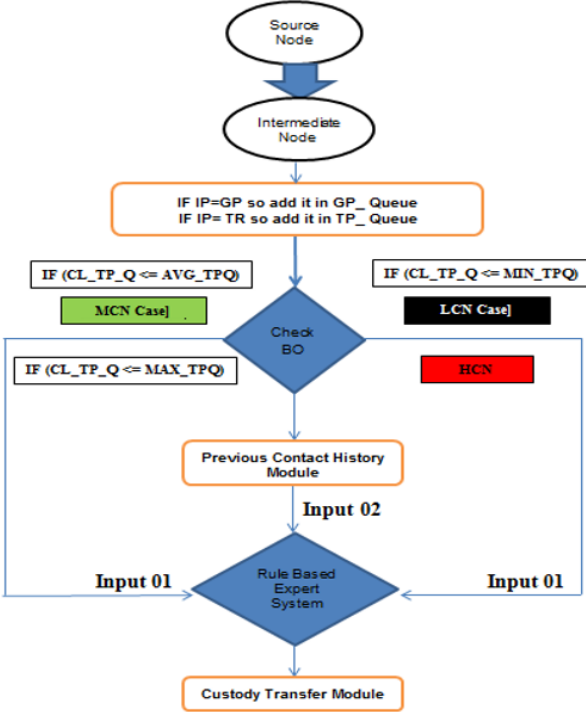
Fig 1: Artificial Intelligence Rule Based Expert System